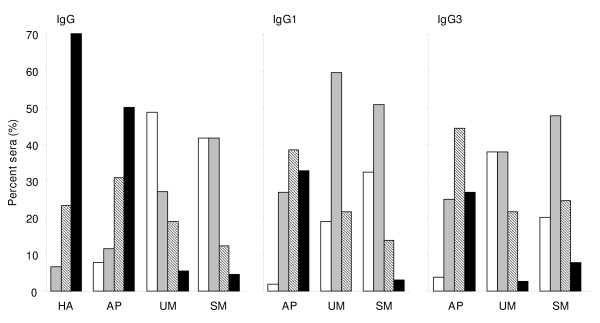
Frequency distribution of the reactivity to one or more PfEMP1-varO domain as by groups of healthy adults (HA) and children recruited in 2006 (AP, UM or SM as indicated) and by Ig assay as indicated (total IgG for HA; total IgG, IgG1 and IgG3 for AP, UM and SM). Reactivity was assessed by ELISA on individual domain as indicated in the Methods section. A plasma sample was classified as seropositive when the recorded signal was above the threshold. Seroreactivity to 1, 2 or 3 domains is indicated irrespective of the actual domain recognized in each class. Symbols used for bars: no domain recognized (white), any one domain recognized (grey), two domains recognized (hatched), all three domains recognized (black).